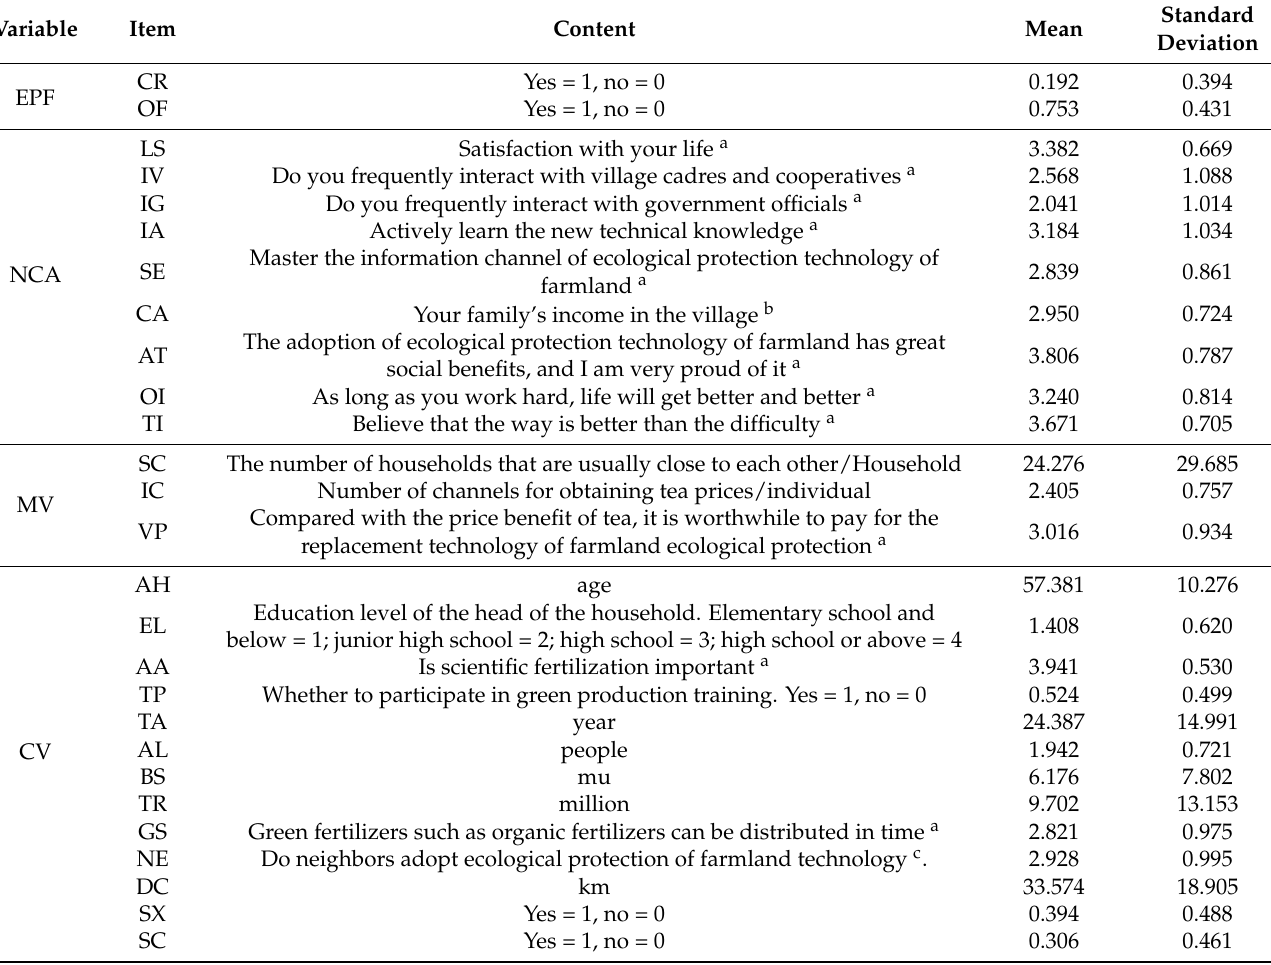
Table 1. Variable description and descriptive